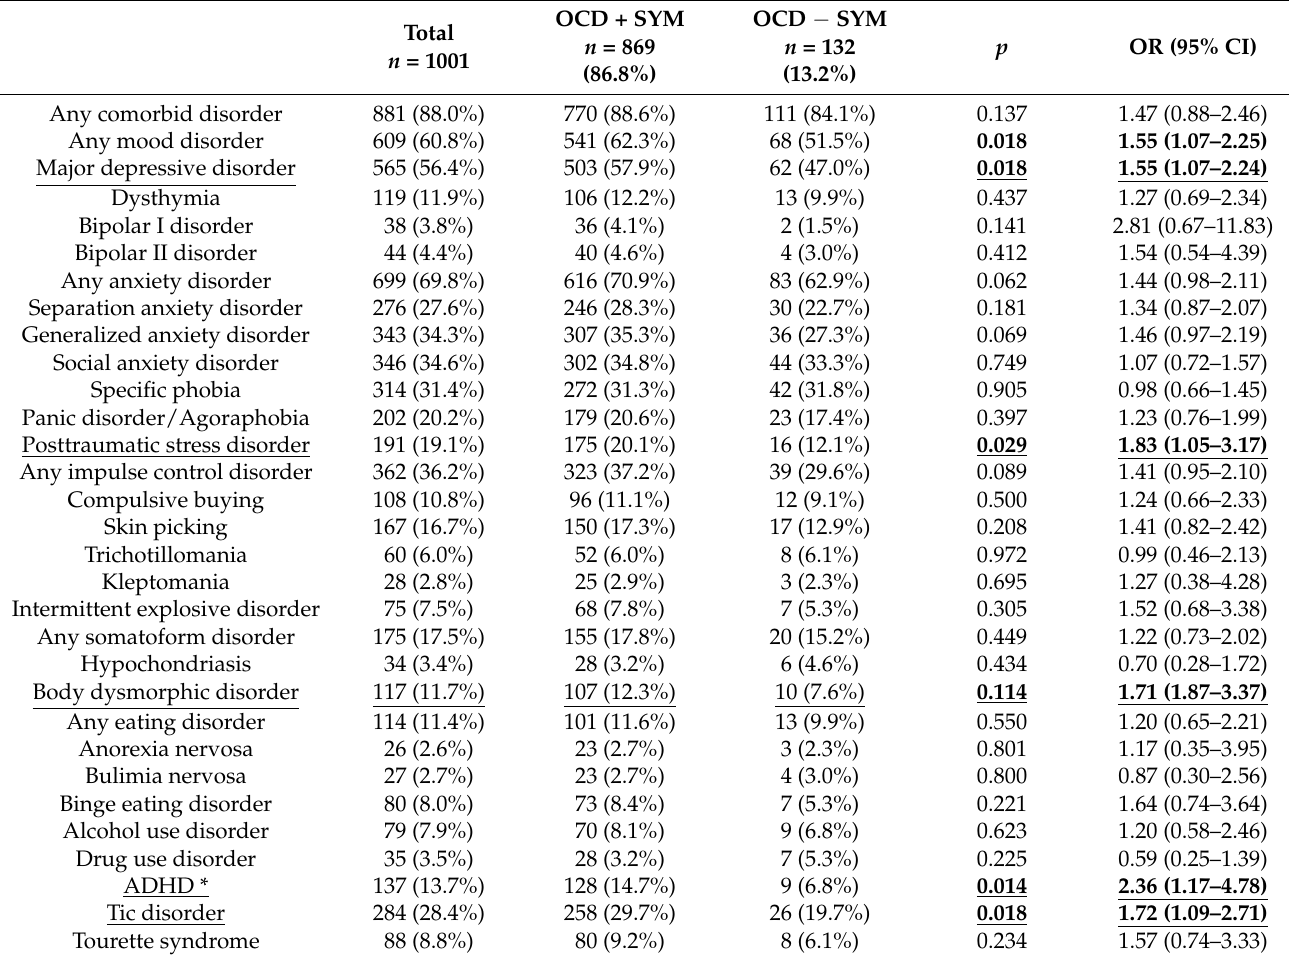
Table 3. Lifetime comorbid disorders of 1001 OCD patients with (OCD + SYM) and without (OCD − SYM) symptoms of the symmetry dimension.